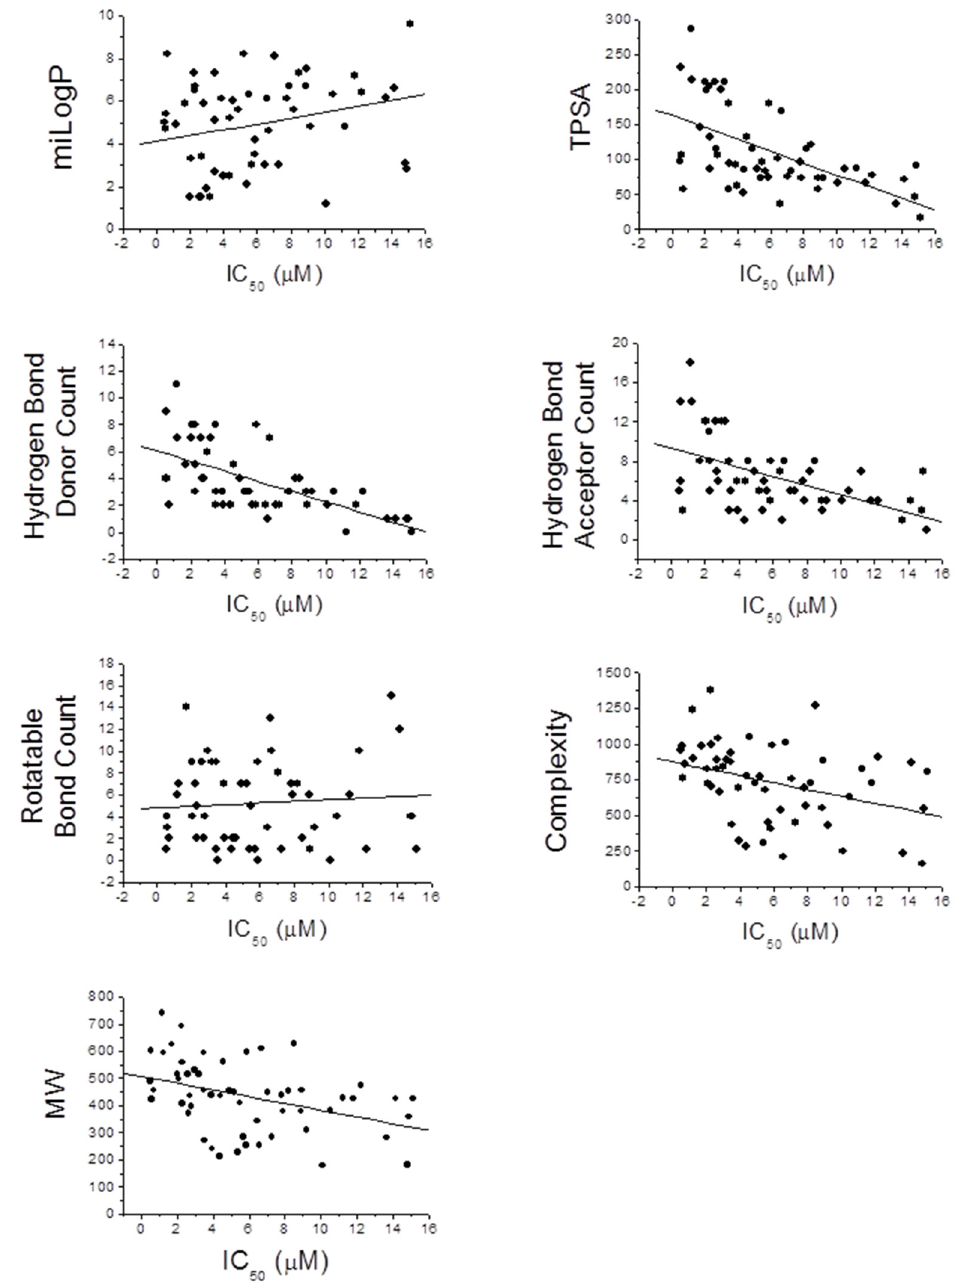
Figure 6. Relationship between the chemical-physical properties and the IC 50 values for PTP1B of the best sixty compounds. Chemical-physical data were recovered from PubChem database and analyzed using OriginPro 2021 Software.